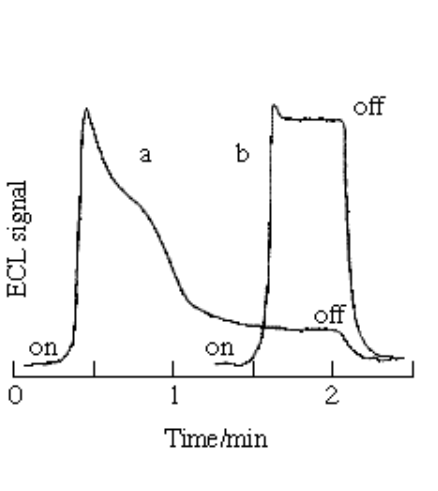
Figure 4. The ECL response of the sensor to oxalic acid (a) and proline (b). The numerals is the concentration (mmol/dm 3